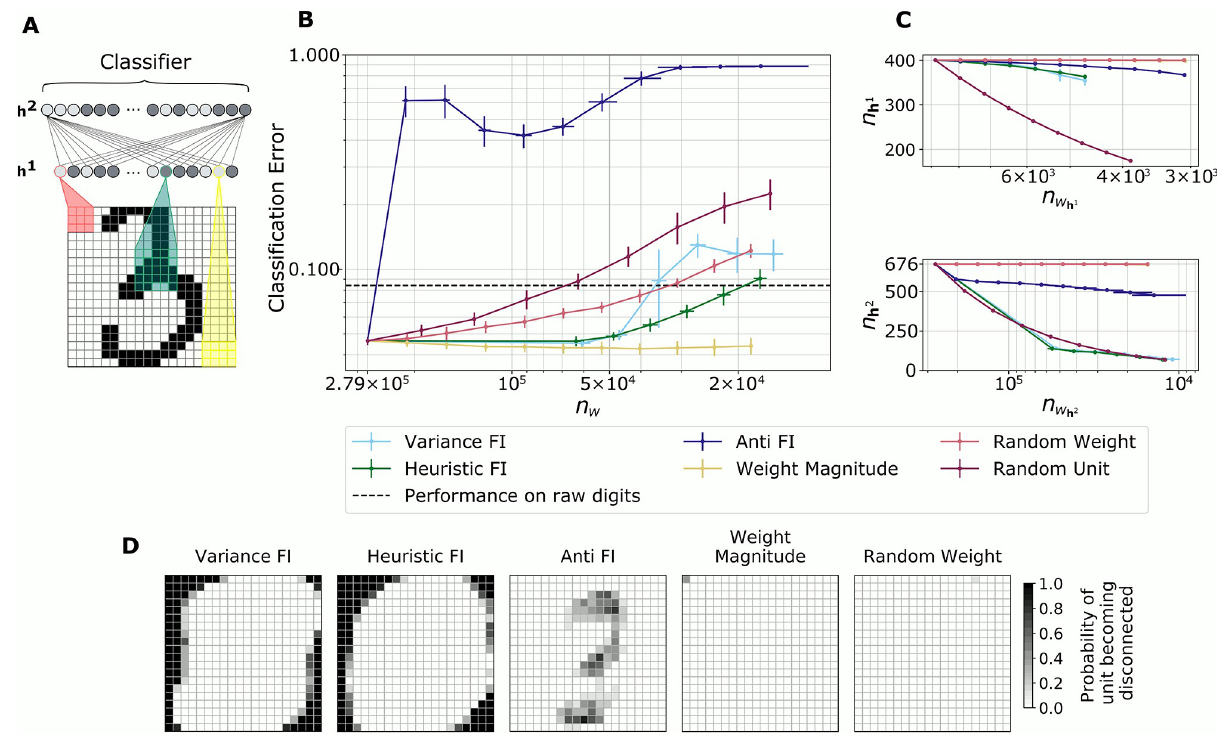
Fig 3. Encoding performance during pruning. (A) Data representation and deep Boltzmann machine architecture. MNIST digits were cropped and binarized. Each unit from hidden layer h 1 had an individual receptive field covering neighboring input pixels; h 2 was fully connected. Only a few connections are shown due to clarity. The classifier was trained on latent encodings from h 2 . (B) Classification error of a logistic regression classifier . The dotted line stands for the baseline error of a classifier trained on the raw digits. All trained on h 2 encodings as a function of remaining weights n w data points are averages from 10 independent simulations, and error bars denote one standard deviation. (C) Number of latent units in h 1 and h 2 as a function of remaining weights over the course of pruning. (D) Final visible layer connectivity after pruning according to different criteria. The probability of a unit being disconnected is shown in gray-scale, with black denoting units that were disconnected in all simulations.